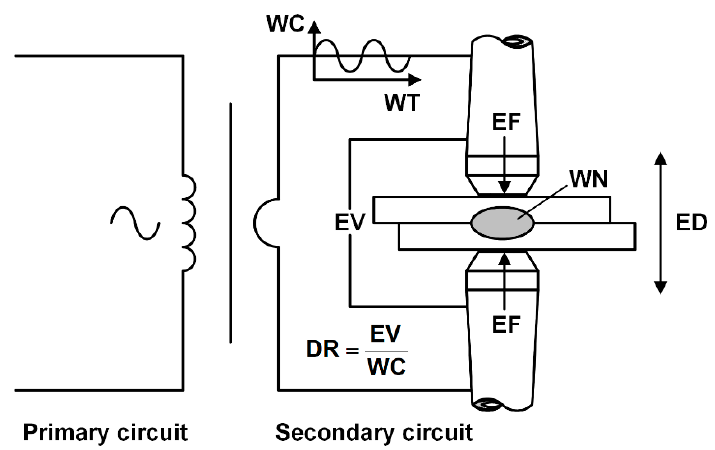
Figure 1. RSW process diagram that shows: (i) the weld nugget (WN) formation after heating by the Joule effect, (ii) the principal welding parameters (welding current (WC), welding time (WT), and electrode force (EF)) [53,54], and (iii) two of the most popular inputs for assessing the quality in RSW (dynamic resistance (DR) [48,49] and electrode displacement (ED) [50–52]).